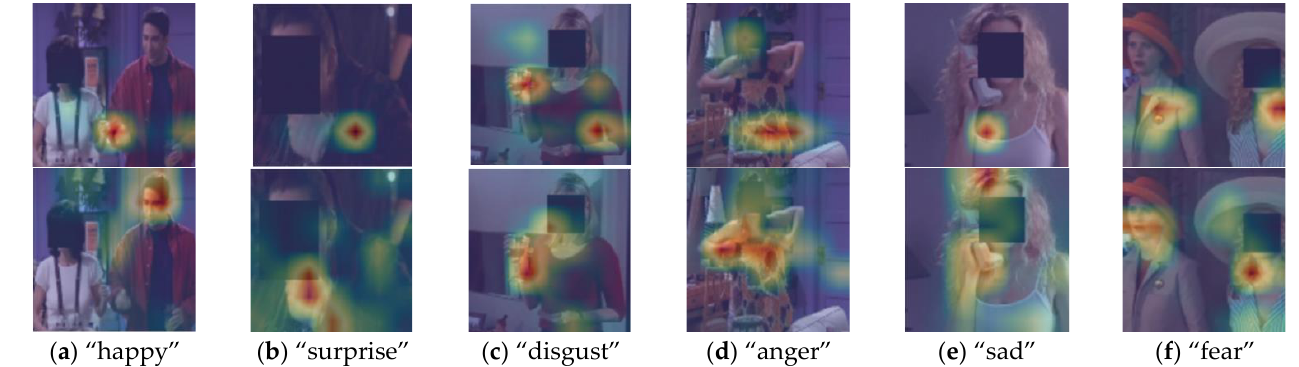
Figure 11. Visual attention heat maps on the CAER-S dataset. The first row shows the heat maps of CAER-Net-S. The second row illustrates the heat maps of our model.